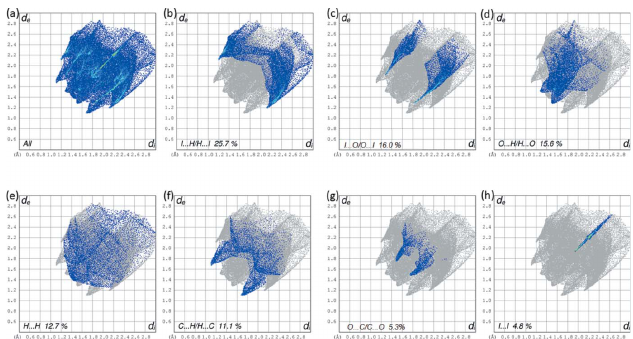
Figure 9 ( a ) The full two-dimensional fingerprint plot calculated for DINT and those delineated into ( b ) I (cid:2)(cid:2)(cid:2) H/H (cid:2)(cid:2)(cid:2) I contacts, ( c ) I (cid:2)(cid:2)(cid:2) O/O (cid:2)(cid:2)(cid:2) I contacts, ( d ) O (cid:2)(cid:2)(cid:2) H/H (cid:2)(cid:2)(cid:2) O contacts, ( e ) H (cid:2)(cid:2)(cid:2) H contacts, ( f ) C (cid:2)(cid:2)(cid:2) H/H (cid:2)(cid:2)(cid:2) C